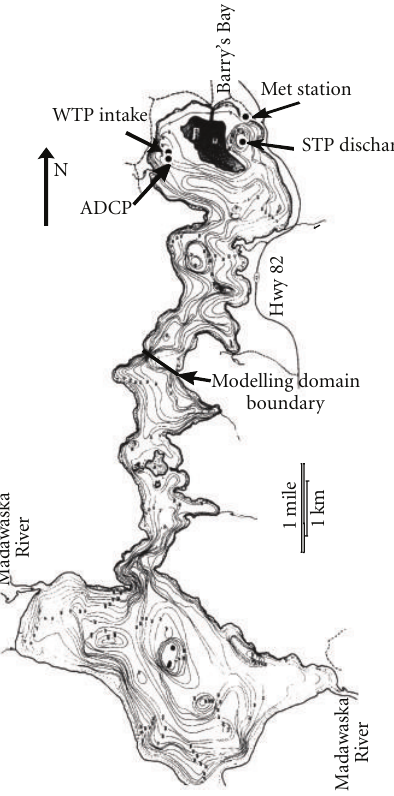
Figure 1: Kamaniskeg Lake map, study region (above the black line area) and locations of the deployed instruments, intake, and